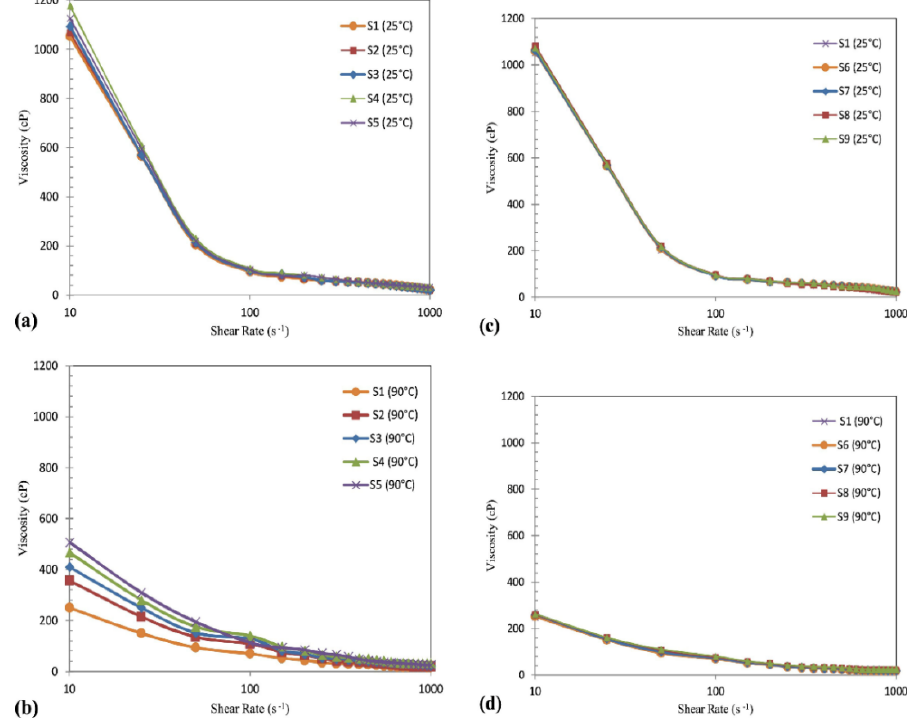
Figure 5. Temperature e ff ects on viscosity: ( a , b ) nano clay / SiO 2 WBDF (S2-S5) and ( c , d ) SiO 2 WBDF (S6-S9) at 25 and 90 ◦ C compared to base fluid (S1). Reprinted with permission from [29]. Copyright Elsevier,